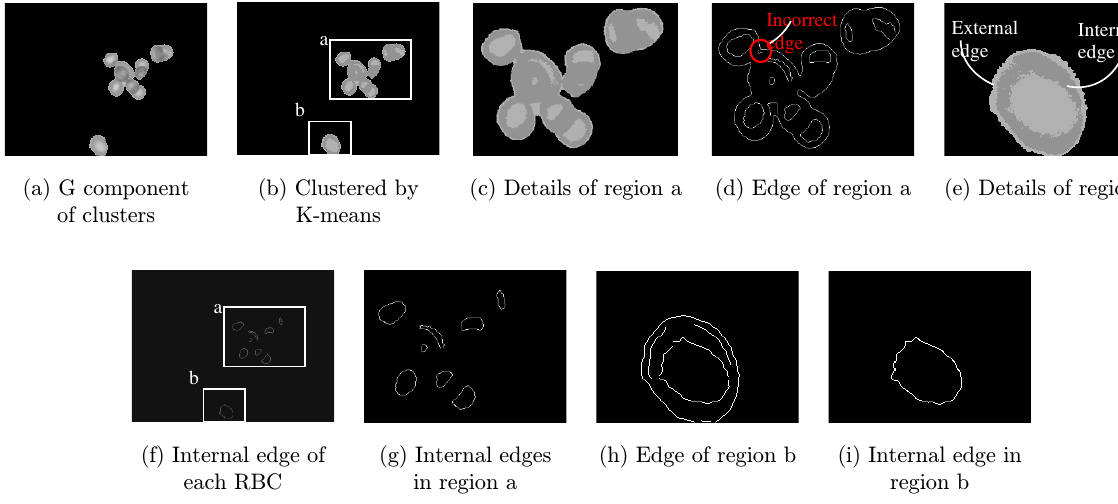
Fig. 5. Processing of overlapping cluster